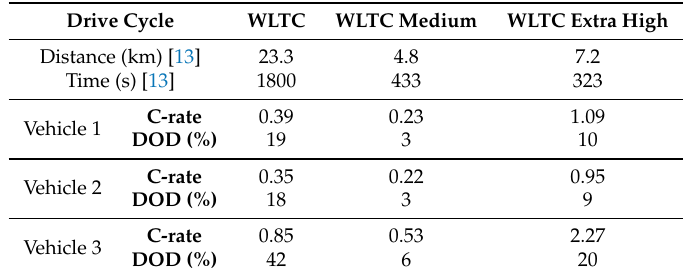
Table 5. Results from the vehicle model for the three vehicles running the Worldwide Harmonized Light Vehicles Test Cycle (WLTC) drive cycles.